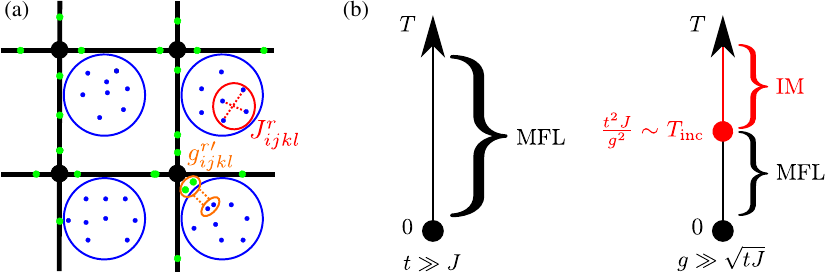
FIG. 1. (a) Our microscopic model. Itinerant conduction electrons (green) hop around on a lattice (black). At each lattice site, they interact locally and randomly with SYK quantum dots (blue) through an interaction (orange) that independently conserves the numbers of conduction and island electrons. (b) Finite-temperature regimes of the model. When the conduction electron bandwidth is large enough, it realizes a disordered marginal-Fermi liquid (MFL) for the conduction electrons for all temperatures T ≪ J (Sec. III A). For a finite bandwidth, there can be a finite-temperature crossover to an incoherent metal (IM), in which all notion of electron momentum is lost, if the coupling g is large enough (Sec. III B). Note that we always have J ≫ T and J ≳ g